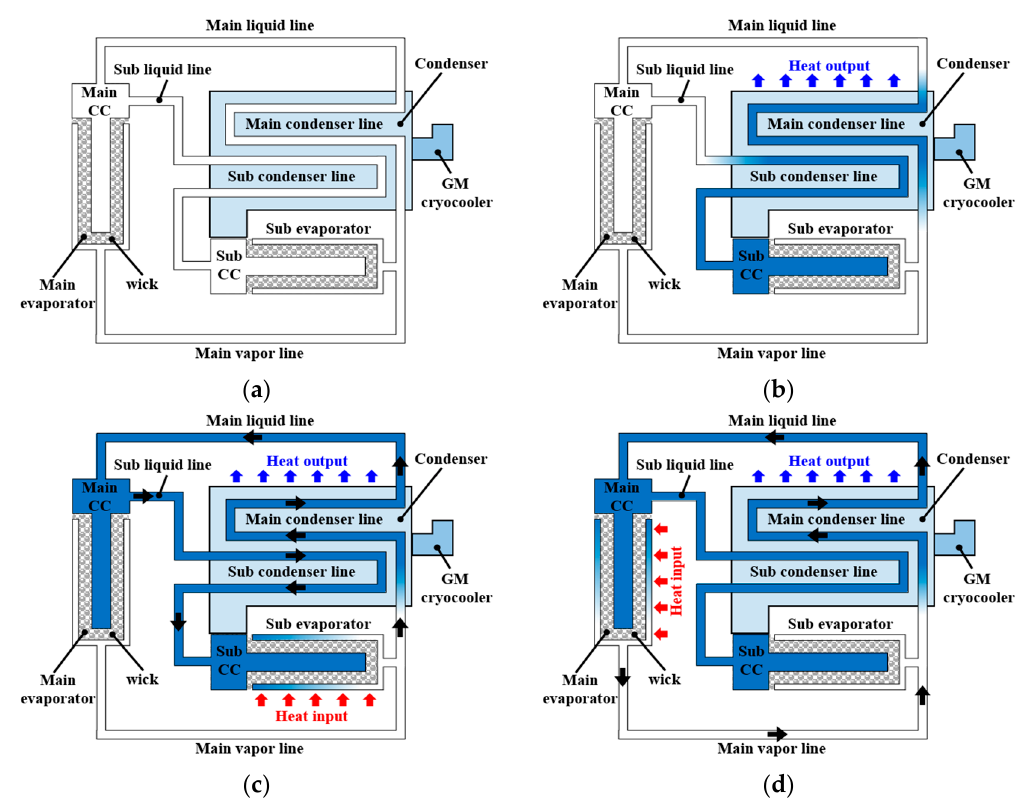
Figure 1. Schematic and operation sequence of the CLHP: ( a ) initial state; ( b ) cooling complete by supercritical start-up; ( c ) circulation of the subloop; ( d ) circulation of the main loop.